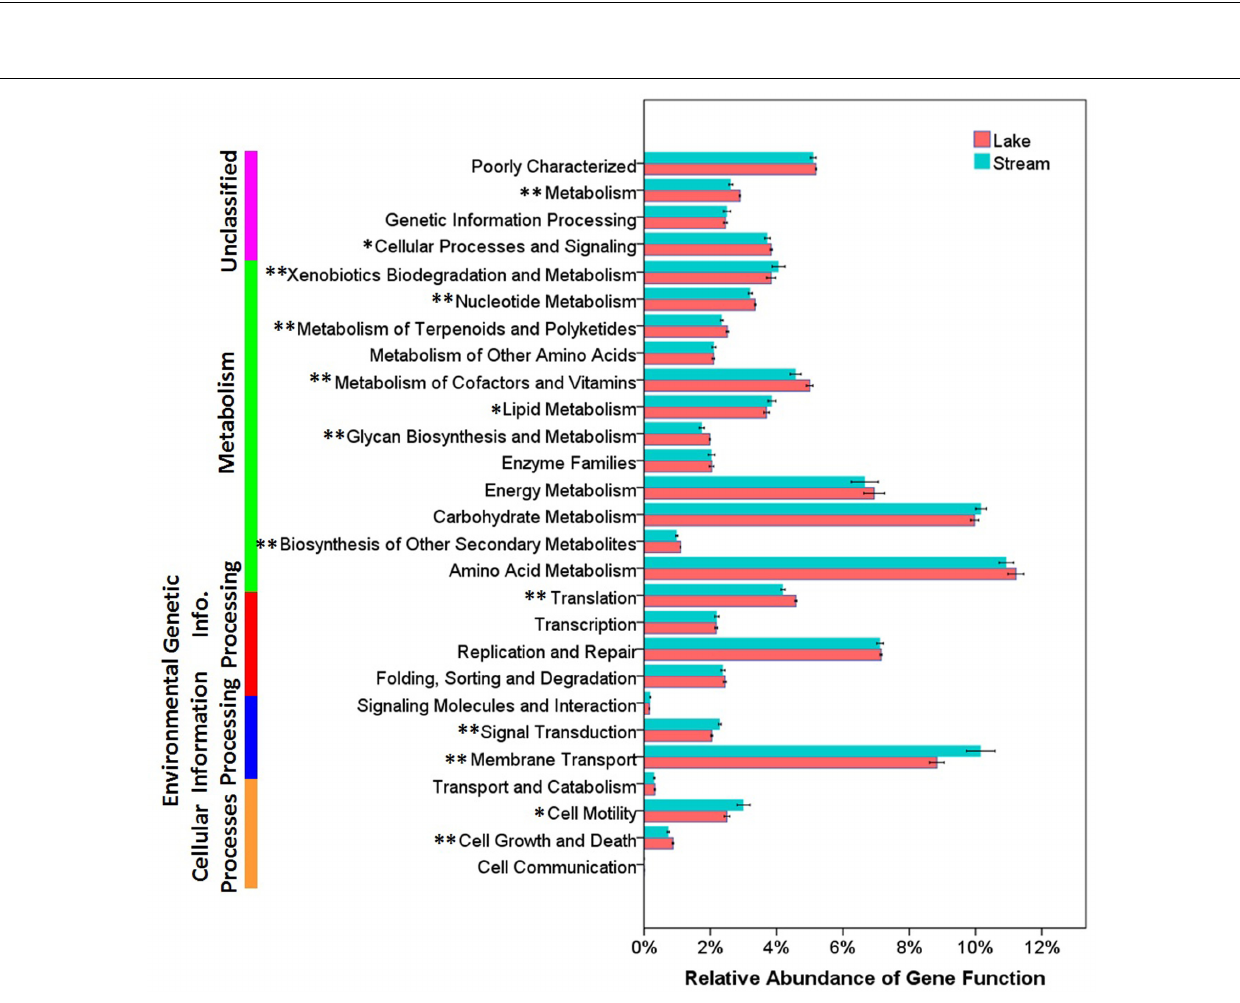
Frontiers in Microbiology |